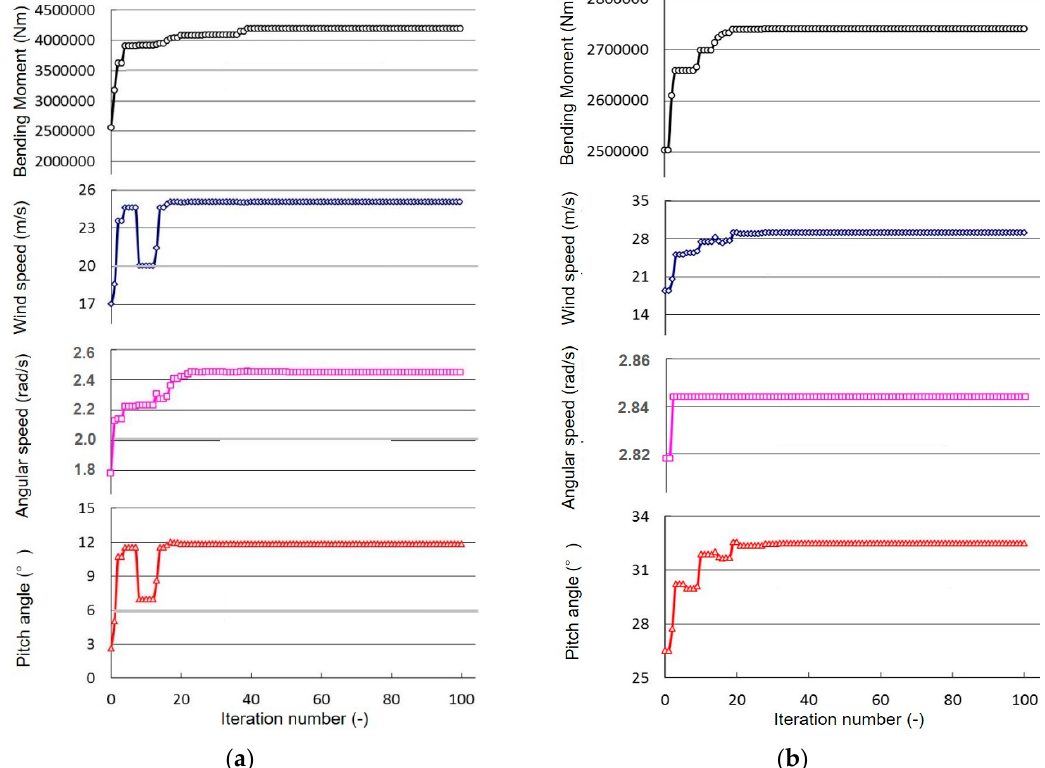
Figure 8. Iterative processes of variables: ( a ) Extreme CMF_ROOT calculation; ( b ) Extreme CMF_ROOT calculation for the 1.5 MW wind turbine blade. Table 1. The extreme values of CMF_ROOT and CME_ROOT.